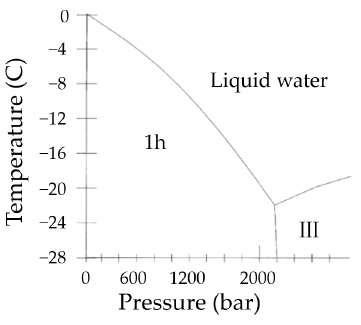
Figure 4. Water phase diagram [22].